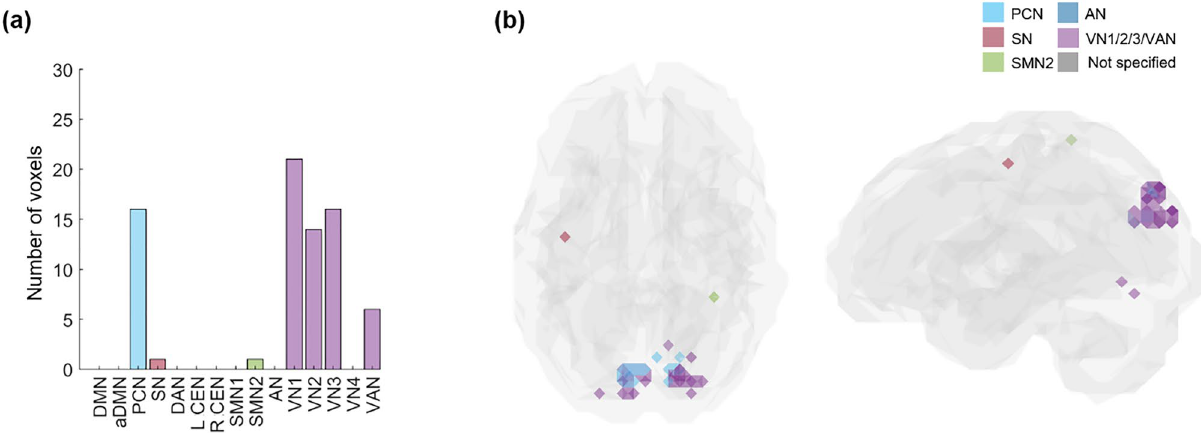
Figure 6. The common core voxels were shared by 60% of individuals. k -core percolation disclosed to which IC subnetworks prevalently among individuals, the k max -core voxels belonged. ( a ) A bar plot showing the affiliation of k max -core voxels. Shared voxels of the precuneus network (PCN), visual network 1 (VN1), VN2, V3, and visual attention network (VAN) were easily found and rare voxels in salience (SN) and sensorimotor network 2 (SMN2). ( b ) The shared voxels on the template brain were visualized. Voxels of k max -core are found in VN and